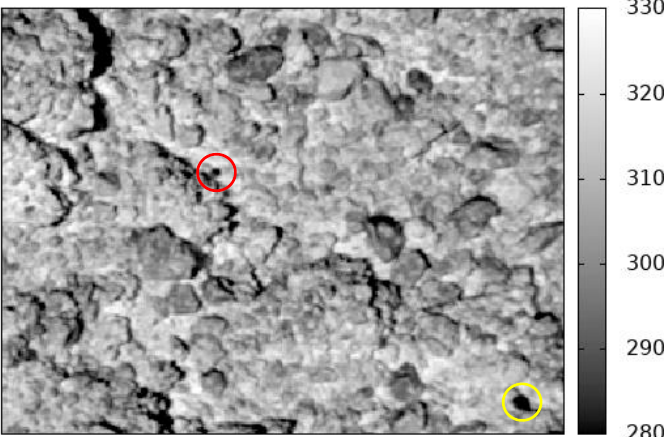
Figure 6. Close-up thermal image taken by TIR on 25 October 2018, during the descent operation of TD1-R3 Campaign. The width of this image is 6 m across. The Target Marker (TM, in the red circle) of the diameter of 10 cm was clearly detected in the thermal image as a “Cold Sphere” beside a 1 m-sized rugged boulder. This thermal image shows the surface is covered with several tens-of-centimeter- to meter-sized boulders larger than the TM and not covered with fine or small grained regolith materials. A very cold boulder (in yellow) is seen at the bottom-right in this thermal image. (Image: hyb2_tir_20181025_024712_l2.fit, © JAXA).